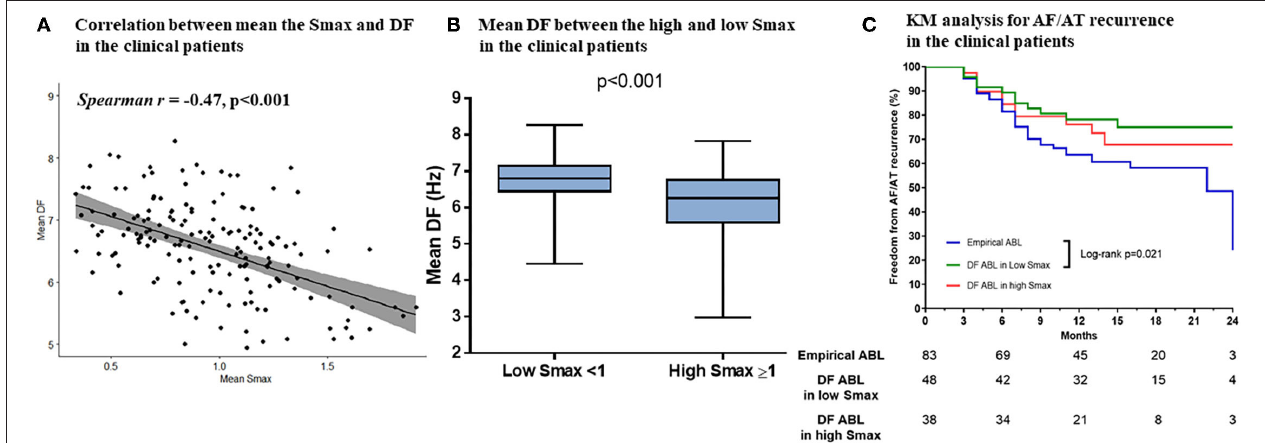
FIGURE 5 | The relationship between the Smax and DF in the clinical patients from the CUVIA AF2 population. The correlation between the Smax and DF in the clinical patients (A) . Comparing the DF between low Smax ( < 1) and high Smax ( ≥ 1) conditions in the clinical patients (B) . Kaplan–Meier (KM) analysis for clinical AF/AT recurrence among three ablation groups in the clinical patients (C) . Smax, the maximal slope of action potential restitution curve; DF, dominant frequency; AF, atrial fibrillation; AT, atrial tachycardia; ABL,